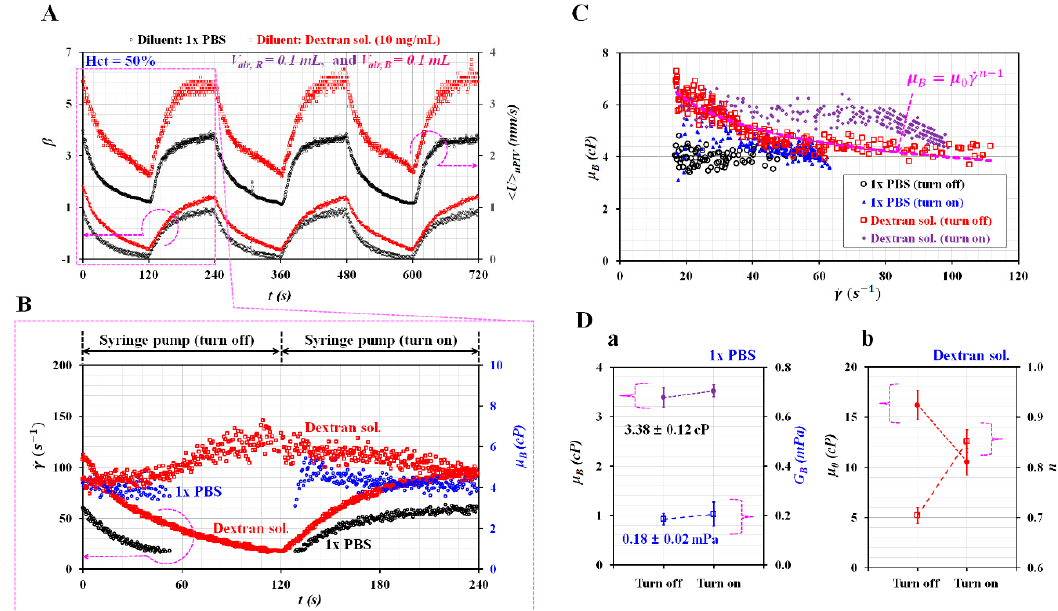
Figure 8. Quantitative evaluation of viscoelasticity with respect to diluent and V air, B = 0.1 mL/h. A blood sample (Hct = 50%) was prepared by adding normal RBCs into diluent, i.e., 1 × PBS and dextran solution (10 mg/mL). The flow rate of each syringe pump was set to Q 0 = 0.5 mL/h. The air cavity of the reference fluid syringe was set to 0.1 mL. ( A ) Temporal variations of β and <U> μ PIV with respect to diluent. ( B ) Temporal variations of γ and µ B with respect to diluent during a single period of 240 s. ( C ) Variations of µ B with respect to diluent and syringe operation (turn-o ff and turn-on). ( D ) Variations of viscoelasticity with respect to diluent and pump operation. (a) Variations of µ B and G B with respect to 1 × PBS and syringe operation. (b) Variations of µ 0 and n with respect to dextran solution (10 mg / mL) and syringe operation.